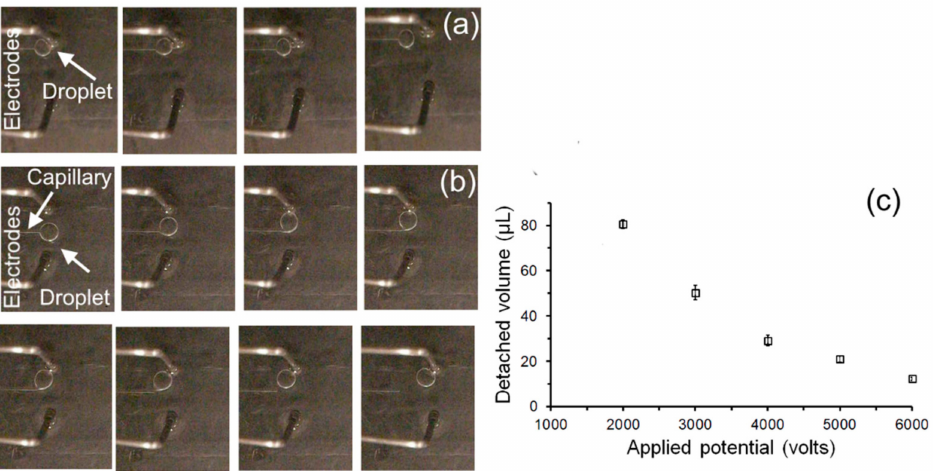
Figure 5. Extraction of a droplet from a capillary tip using electrical tweezer: ( a ) Sequential images of the movement of electrical tweezer close to the water droplet in the absence of an electric field; ( b ) sequential images of the extraction of droplet under the influence of electric potential of 2000 V (V/d = 200 V/mm) at 5 Hz; and ( c ) the dependence of detached droplet volume from the capillary on the applied sinusoidal electric